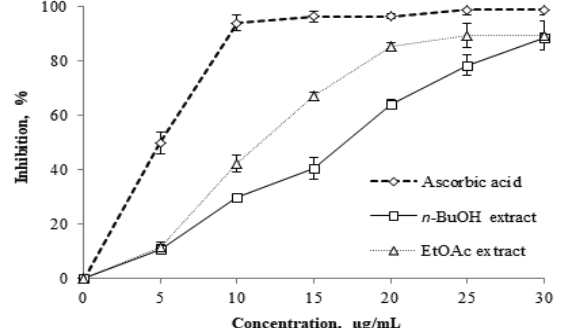
Figure 1 - Free radical scavenging capacity of etOAc and n -BuOH extracts of C. sphaerocephala using DPPH.